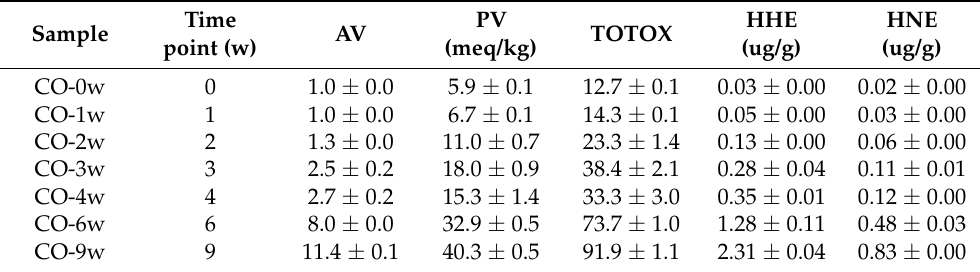
Table 2. AV, PV (meq/kg), total oxidation value (TOTOX) (AV + 2 × PV), and hydroxyalkenals (HHE and HNE, µ g/g) of camelina oil (CO) stored in the dark at 40 0 C with access of oxygen up to 9 weeks (w). Data are mean ( n = 2) shown with standard deviation.